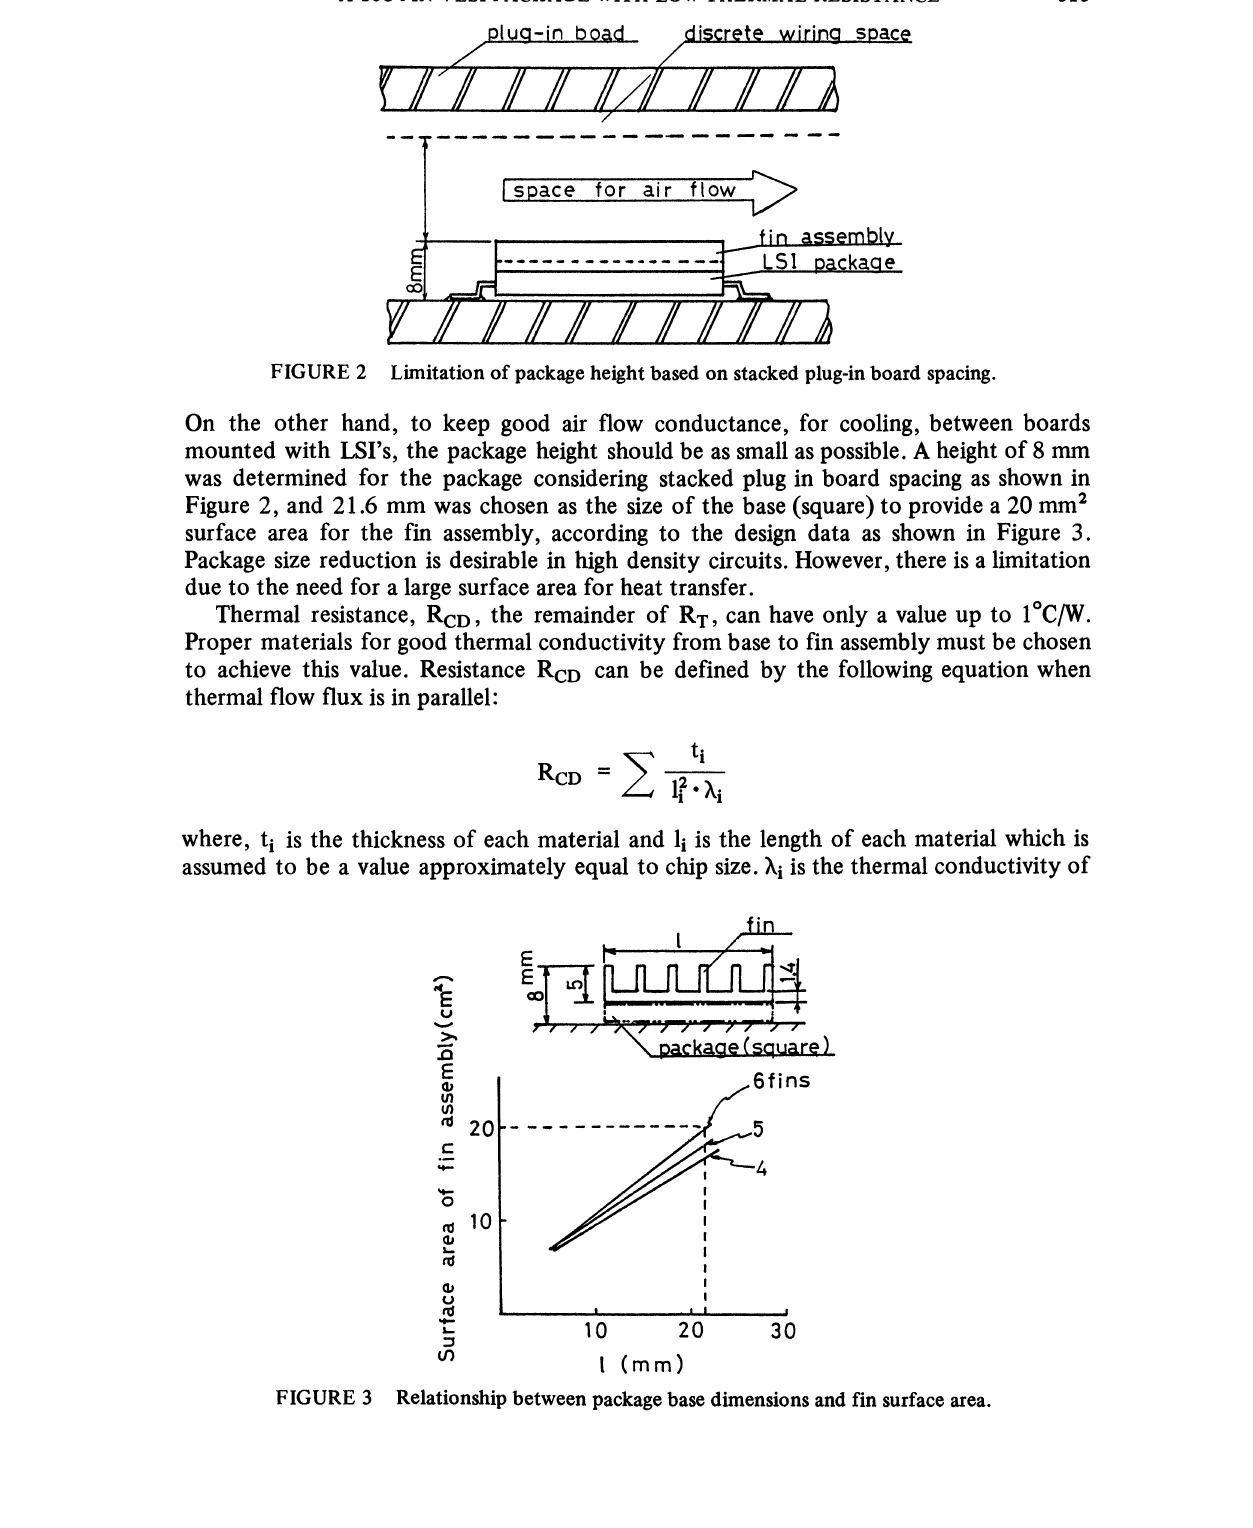
FIGURE 3 Relationship between package base dimensions and fin surface